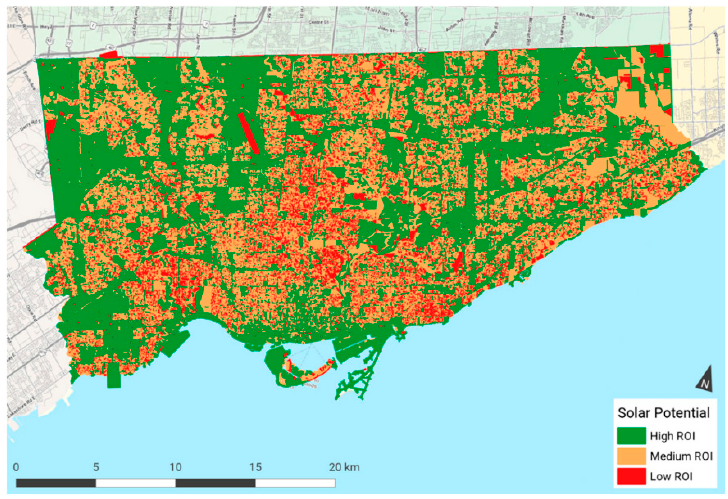
Figure 2. Estimation of solar potential in Toronto City using Lidar-derived DTM